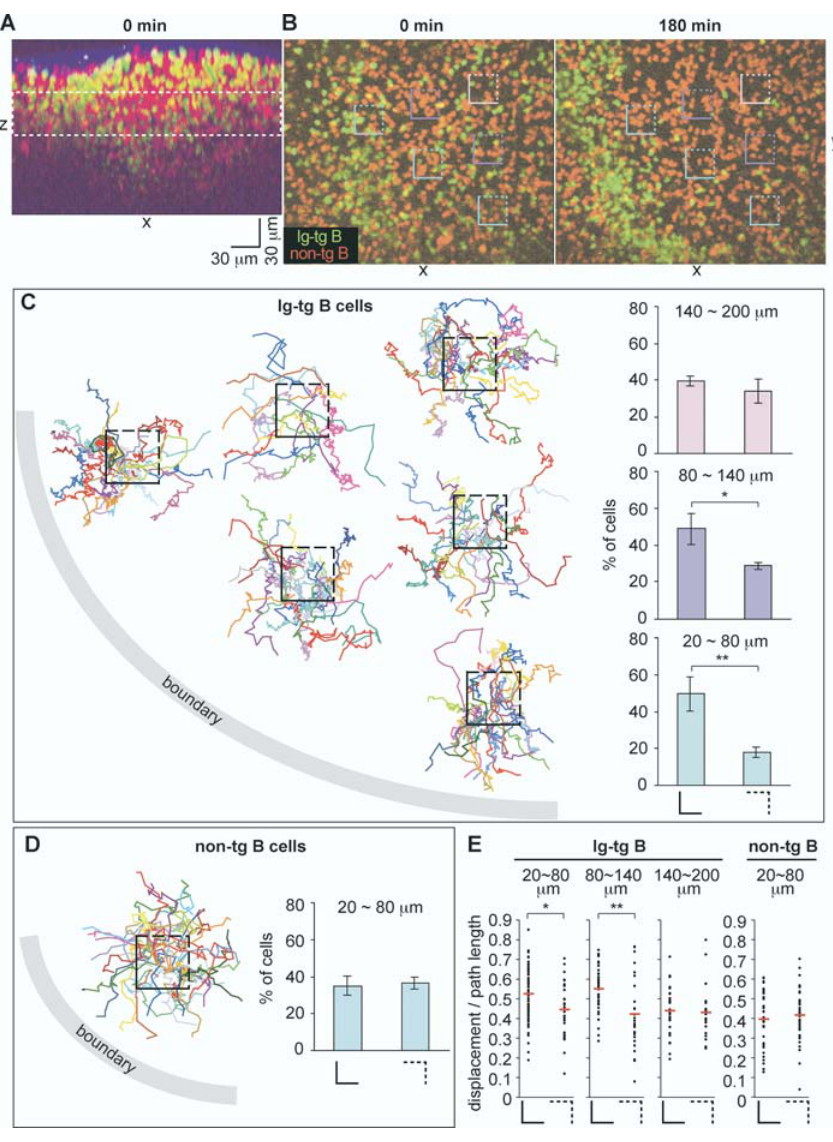
Figure 2. Relationship between Directionality of Ag-Engaged B Cell Migration and Distance from the Follicular Boundary (A) The xz projection view of an image stack collected immediately prior to time-lapse imaging, demonstrating the location of the B cell follicle containing transferred B cells (green and red). The collagen-rich lymph node capsule is visualized by second harmonic emission (blue). The dashed white rectangle shows the region used in the time-lapse image analysis. (B) Time-lapse images of HEL-engaged Ig-tg B cells (green) clustering at the follicle–T zone boundary and naive non-tg B cells (red) in the follicle. The 0-min image is approximately 1 h after antigen exposure (see Video S2). Square boxes indicate regions used for directionality analysis, shown in (C). Scale bar is as shown in (A). (C) Tracks of antigen-engaged B cells originating from 30- l m follicular cubes. The centers of the boxes are placed proportionally to the actual positions of the boxes shown in (A), with each box corresponding to a 30 l m 3 30 l m 3 30 l m cube. Tracks cover 8 to 95 min. The histograms show the percentage of cells that moved across the sides of the square (solid lines) that face the boundary (left histograms) and the percentage of cells that moved across the opposite sides (dashed lines) of the squares (right histograms). The bottom, middle, and top histograms show the results with cubes that are 20–80, 80–140, and 140–200 l m away, respectively, from the boundary. Data shown in the histograms are pooled from three experiments. *, p , 0.05; **, p , 0.01. (D) Tracks of naive B cells originating from inside of the middle blue box shown in (A). Tracks cover 5 to 25 min. The histogram shows the percentage of cells that moved across the solid or dashed sides of cubes that are 20–80 l m away from the boundary. Data shown in the histogram are from three experiments. (E) The dot plots show ratios of the displacement to the path length of 8-min tracks of antigen-engaged B cells (left three graphs) or naive B cells (far right graph) originating from the cubes described in (B–D). The distances from the cubes to the boundary are indicated above the graphs. The left and right plots in each graph are the data of tracks that cross the solid and dashed sides of the cubes, respectively. All (100%) of Ig-tg B cells and 94% of non-tg B cells that crossed the sides of the cubes could be tracked for 8 min. The means of each data group are shown as red bars. *, p , 0.05; **, p , 0.01. DOI: 10.1371/journal.pbio.0030150.g002